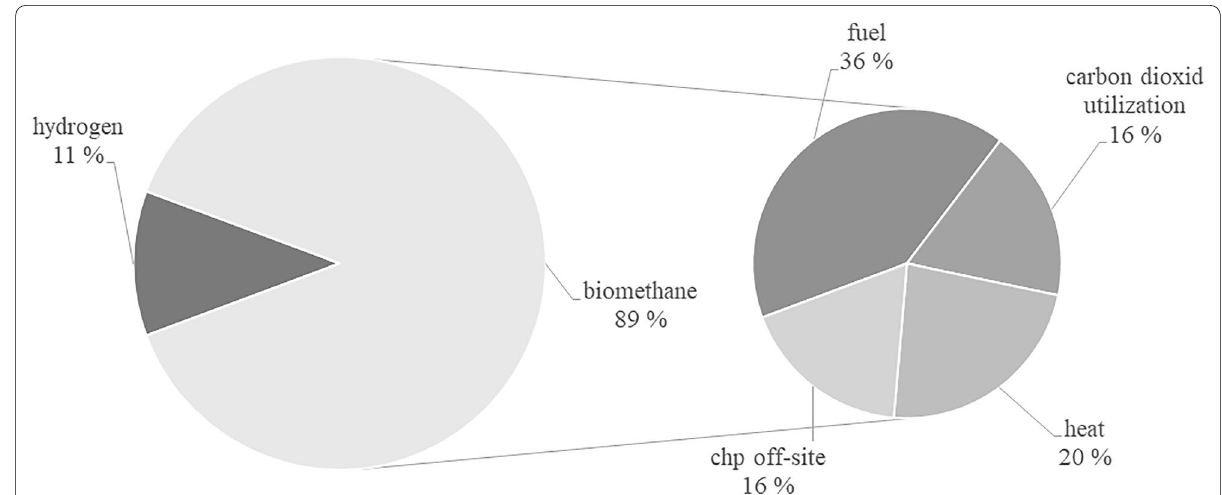
Fig. 6 Share of the utilization pathways considered after biogas upgrading, n